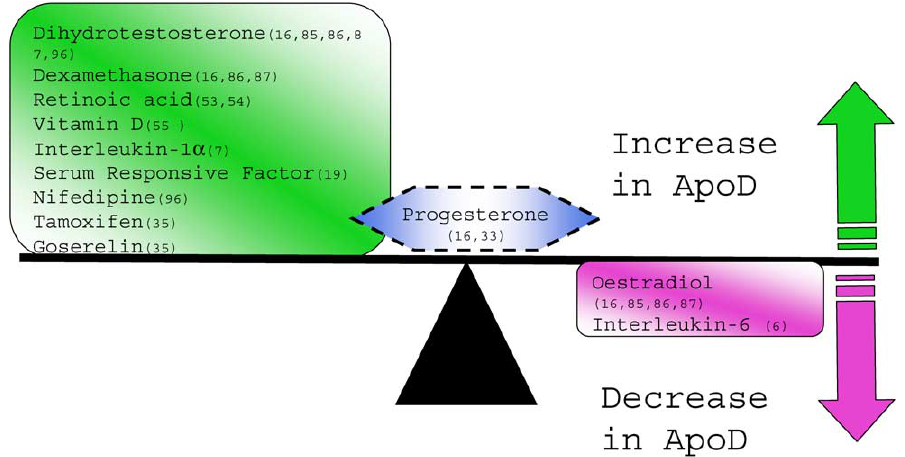
Fig. 3. Regulation of ApoD transcription. Factors on the left side (indicated in green) increase transcription. Factors on the right side (indicated in purple) decrease transcription. In the middle (in blue) is progesterone, which may both increase and decrease ApoD expression and sometimes has no influence at all on transcription. Figures in brackets correspond to the reference list. Of note are the well-documented stimulating effect of androgens and glucocorticoids and the inhibiting effect of oestradiol. The mechanism of tamoxifen and goselerin in increasing ApoD transcription is through inhibition of oestradiol. (Oestradiol has an inhibitory effect on the